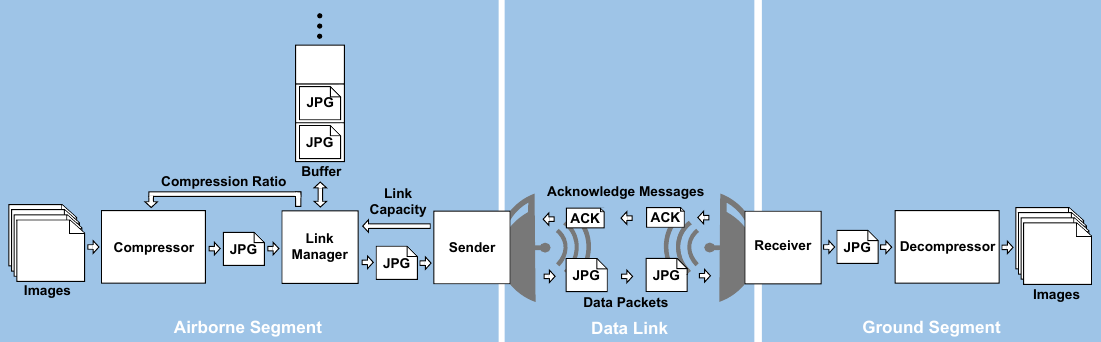
Figure 8. Real-time data transmission chain. The control loop at airborne segment adjusts compression ratio depending on data link capacity (i.e., its current available bandwidth) and/or transmitter’s buffer fill